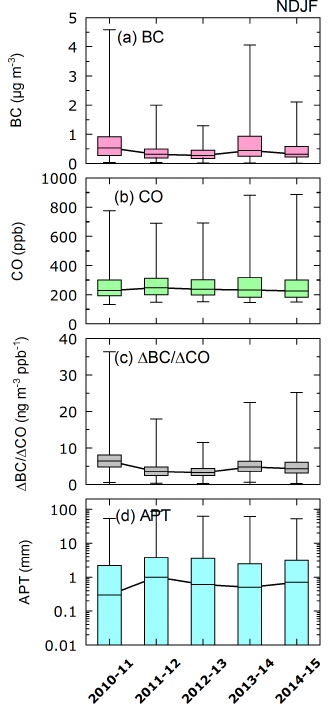
Figure 11. Interannual variations in (a) BC mass concentrations, (b) CO mixing ratios, (c) (cid:49) BC /(cid:49) CO ratios, and (d) APTs, during November–February for 5-year